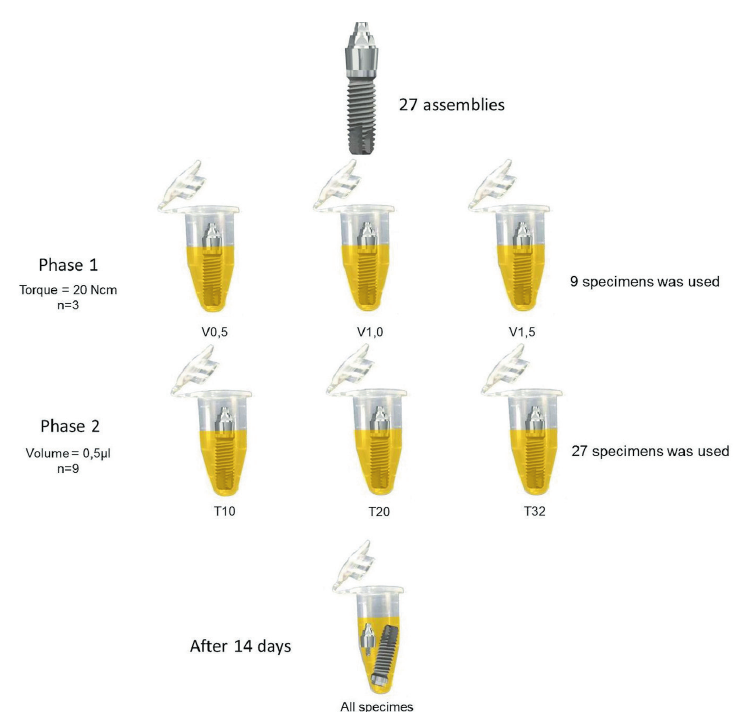
Figure 1- Study flow chart